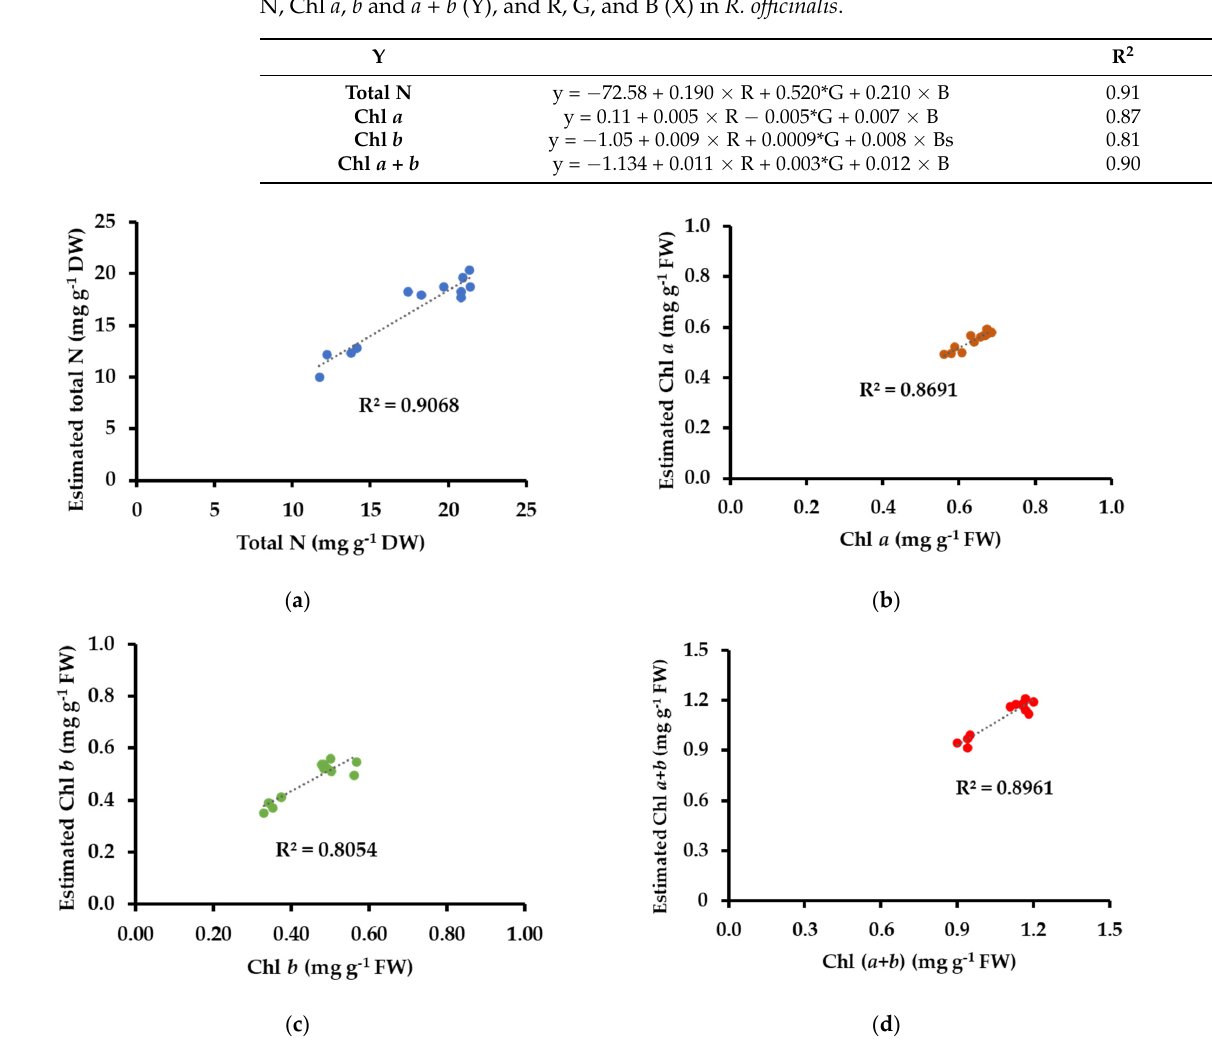
Figure 4. Visualization of the different correlations studied in R. officinalis. ( a ) Total N (mg g − 1 DW), ( b ) Chl a (mg g − 1 FW), ( c ) Chl b (mg g − 1 FW), ( d ) Chl a+b (mg g − 1